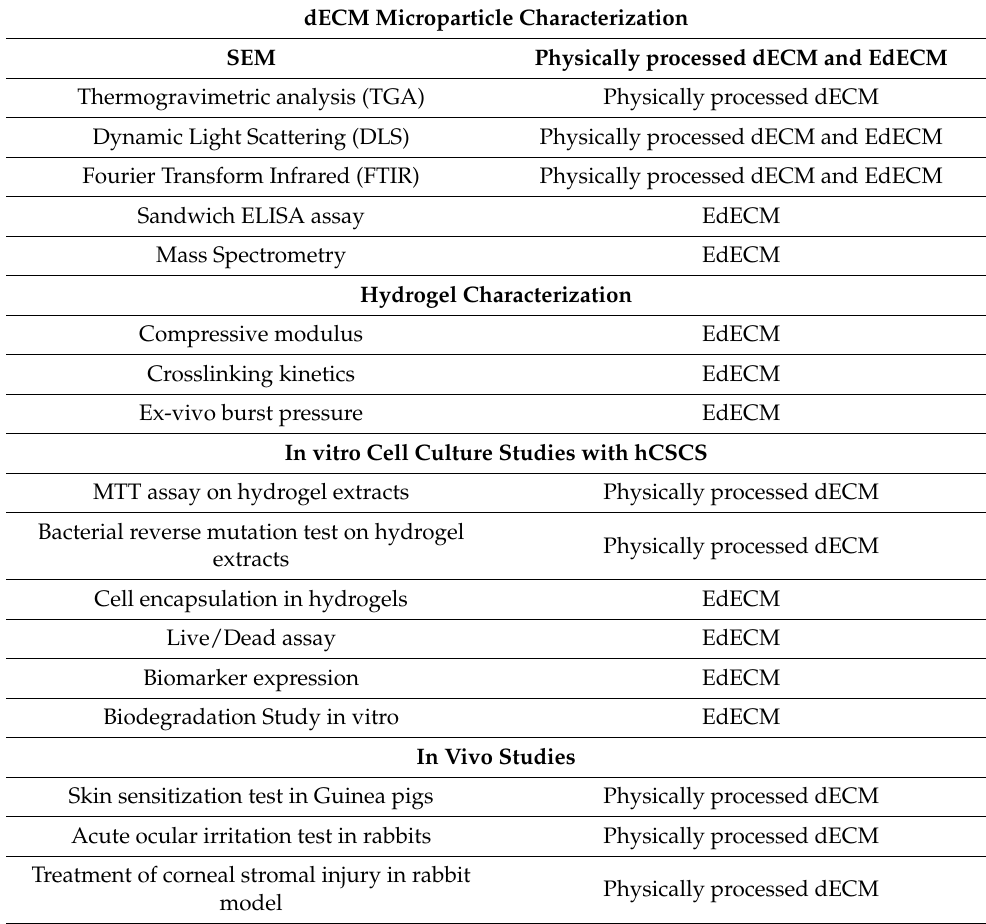
Table 1. List of formulations used for the various characterization